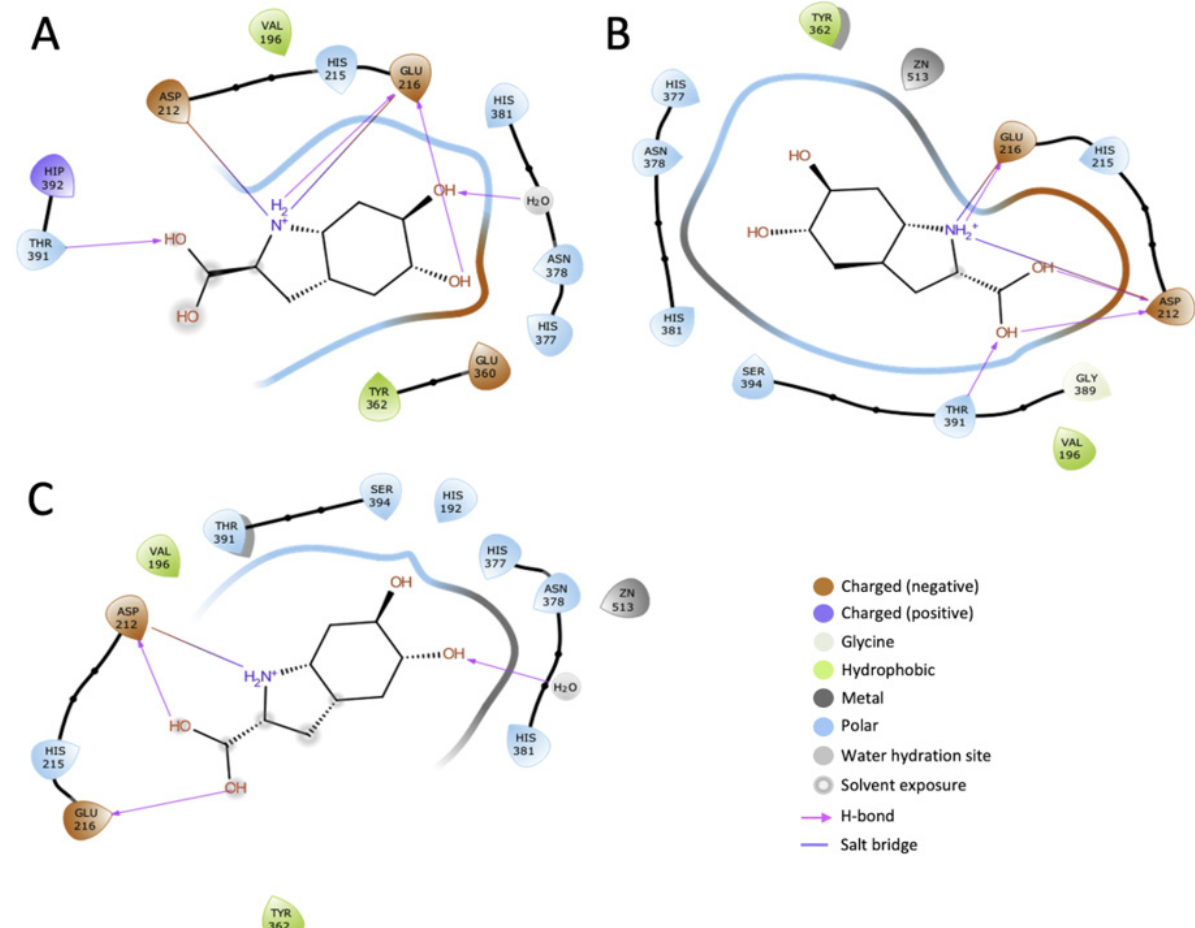
Figure 7. Docked DHICA interaction with Tyrp1 ( A ), D308N ( B ), and R326H ( C ). Tyrp1 and D308N have six total interactions with DHICA: four hydrogen bonds and two salt bridges. R326H has two fewer interactions with DHICA: three hydrogen bonds and one salt bridge. Table 3. Ligand–receptor interaction-related distances.